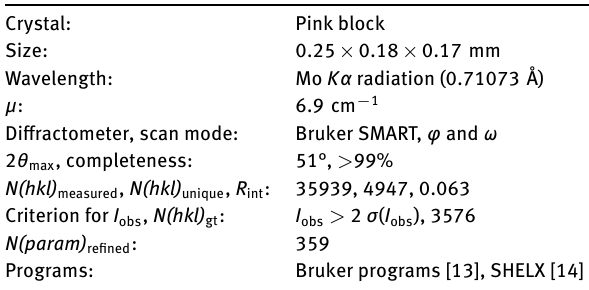
and measurement conditions and a list of the atoms including atomic coordinates and displacement